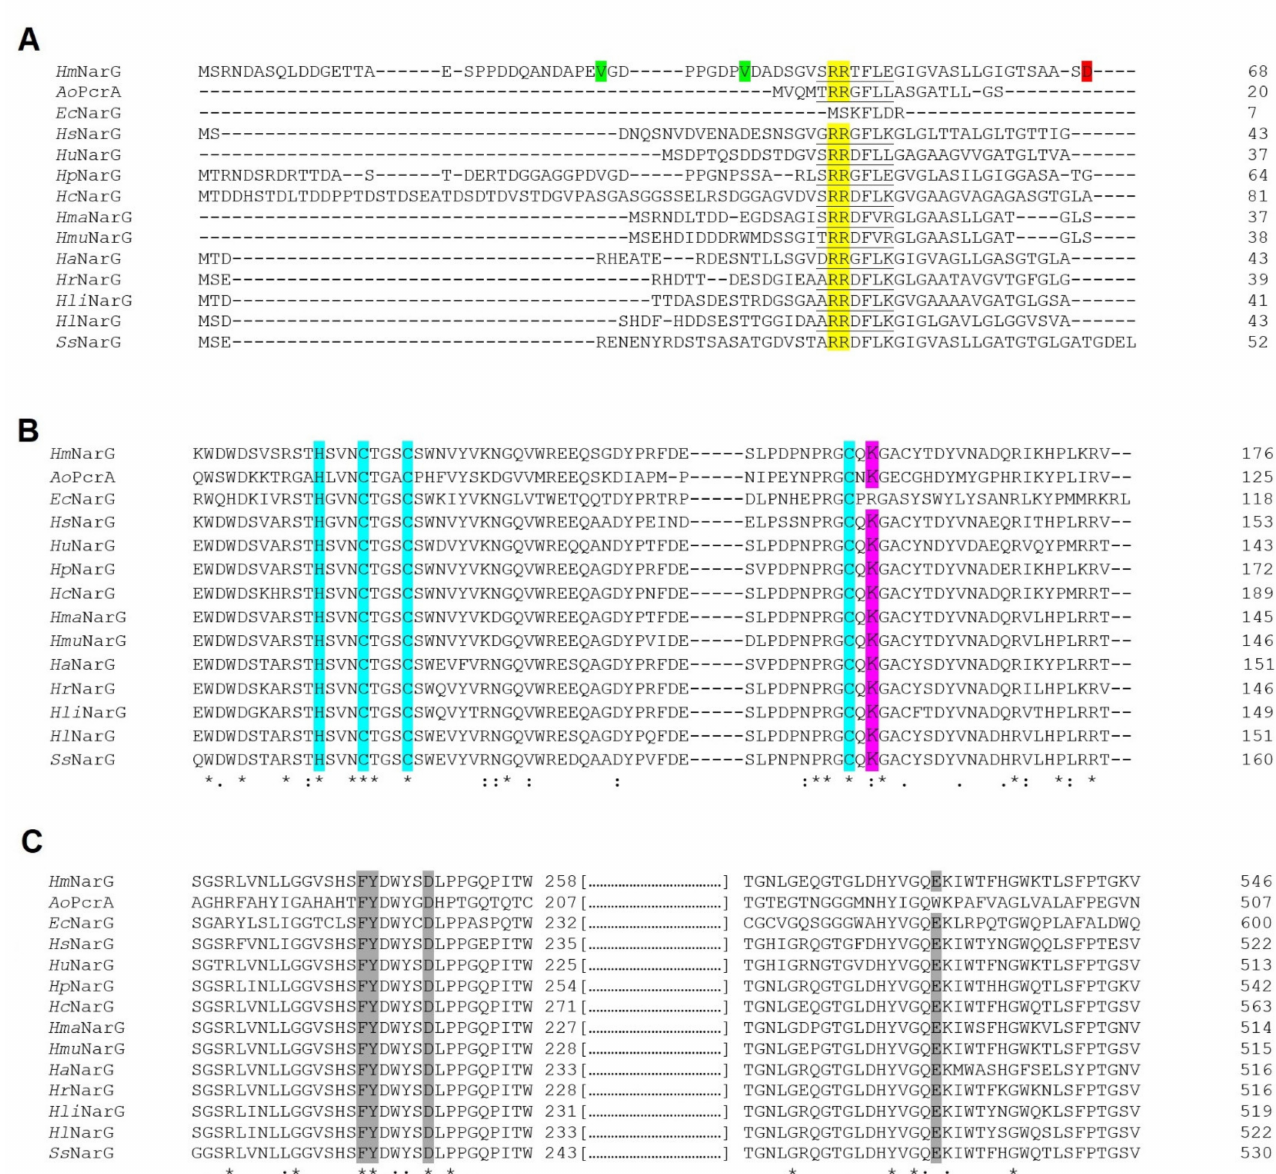
Figure 2. Clustal omega alignment of Azospira oryzae ( Ao PcrA; Protein NCBI ID: WP_014235273.1), Escherichia coli ( Ec NarG; Protein NCBI ID: WP_000032939.1), Halococcus salifodinae ( Hs NarG; Protein NCBI ID: EMA48671.1), Halorhabdus utahensis ( Hu NarG; Protein NCBI ID: WP_012795090.1), Haloferax mediterranei ( Hm NarG; Protein NCBI ID: WP_004056332.1), Halo-